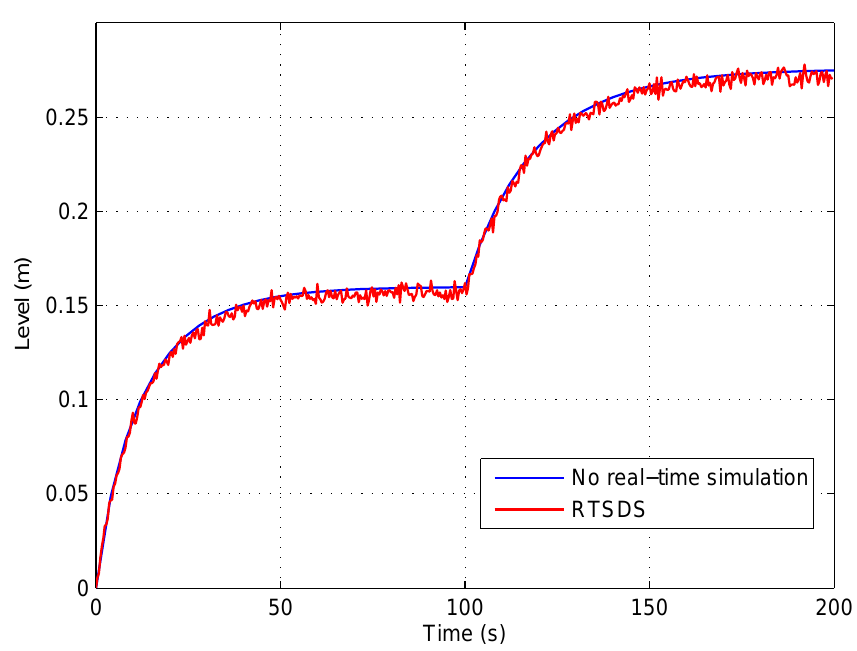
( t ) = 0 . 457 initially and then e